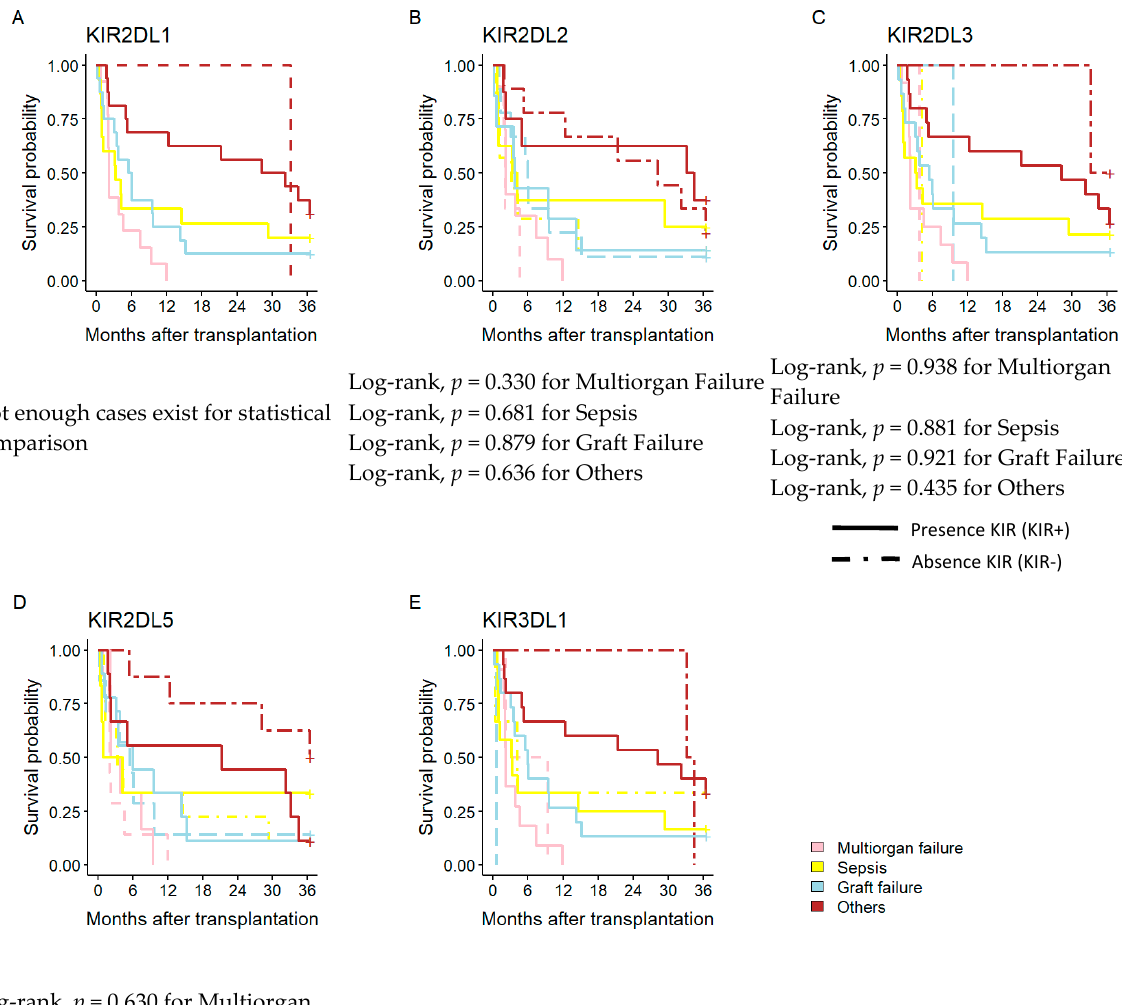
Figure 3. Kaplan–Meier patient survival curves according to the main cause of death and KIR genes.